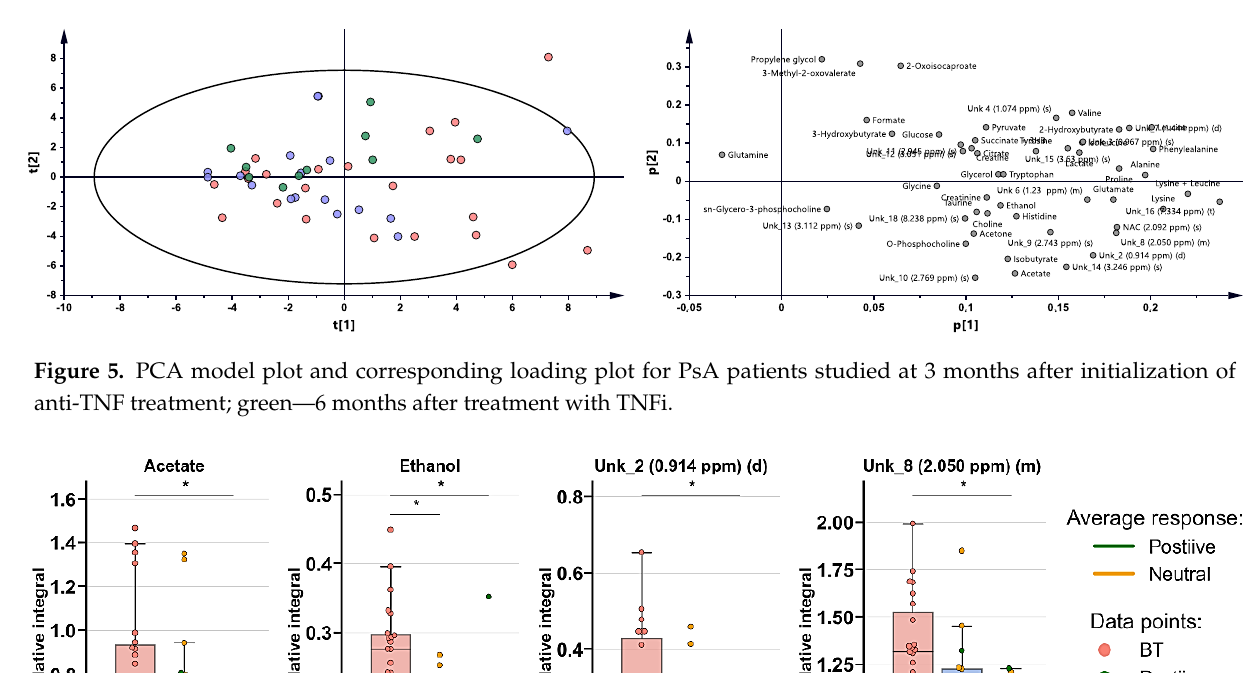
Table 4. The multivariate analysis models summary for RA, AS, PsA comparison.